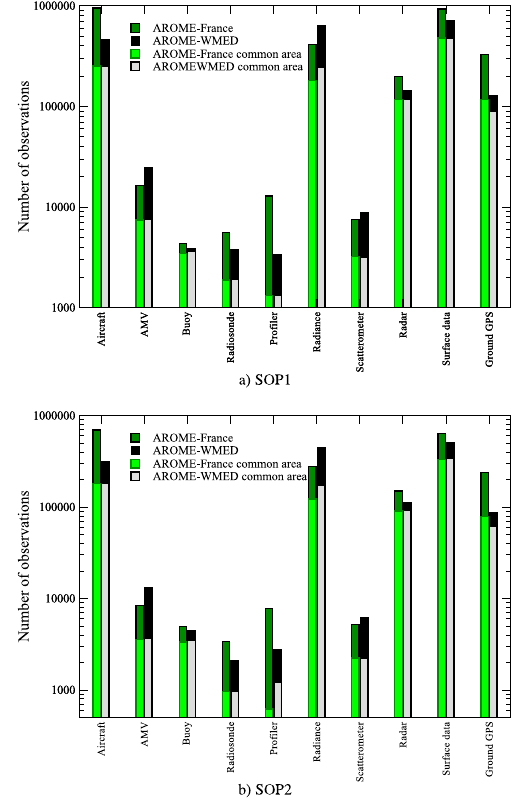
Figure 5. Total number of assimilated observations by each model (a) during the SOP1 period (05 September, 00:00UTC to 05 November 2012, 21:00UTC) and (b) for the SOP2 (01 February, 00:00UTC to 15 March 2013, 21:00UTC); y axis uses a logarith- mic scale. Light-coloured bars represent the amount of data present in the common area of both models (39 ◦ N to 47.5 ◦ N and from 8 ◦ W to 11 ◦